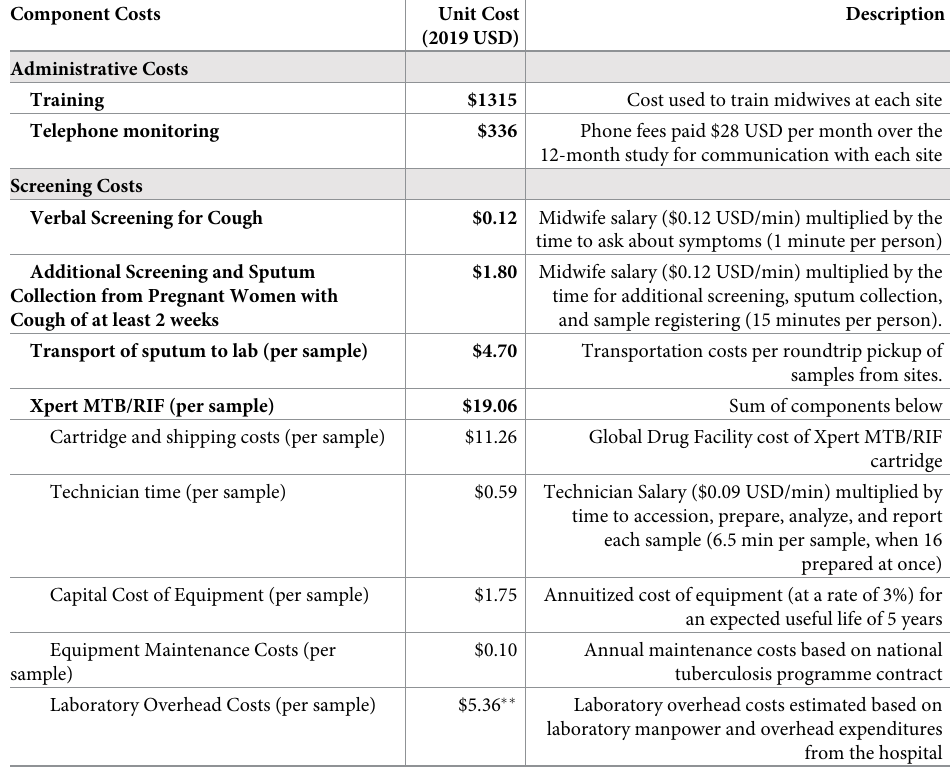
Table 4. Cost components for the cost